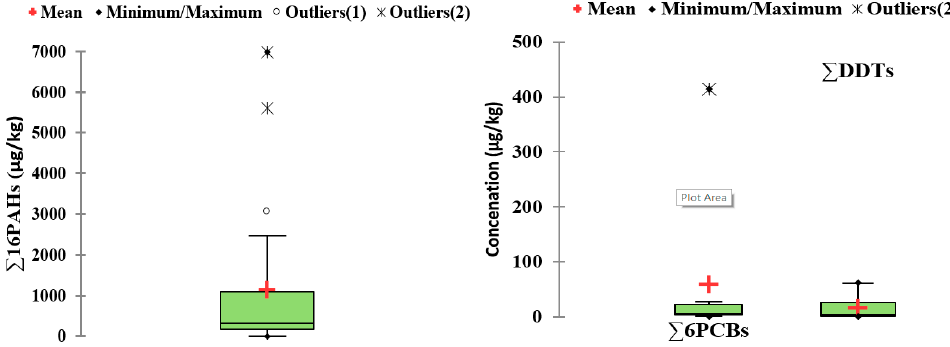
Figure 6. Variation of sum of the 16 PAHs, 6 PCBs and DDTs in the Lower Danube basin.